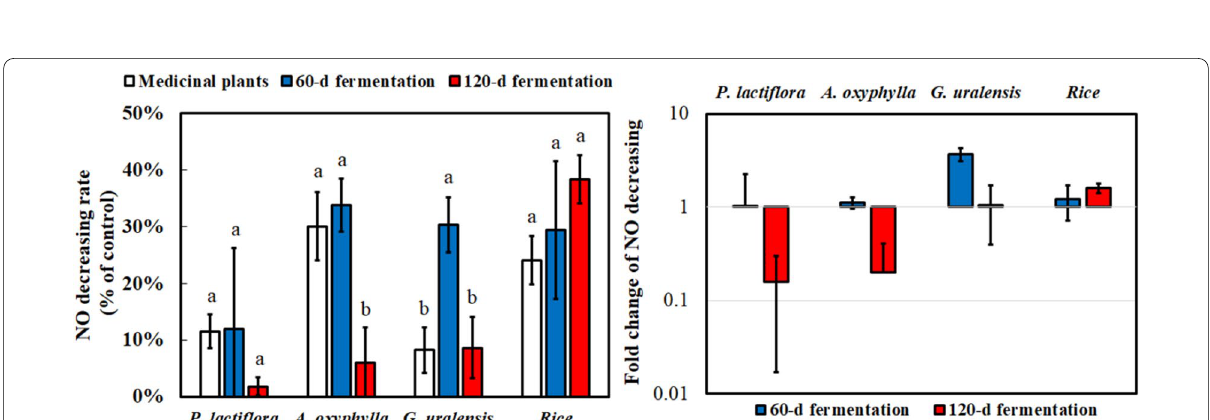
Fig. 4 Anti‑inflammatory capacity using LPS‑stimulated Raw264.7 cell with or without fermentation of medicinal plants at 0.5 mg/mL by M. ruber BCRC 31535. The ratio of 60 and 120 days of fermentation to medical plants was depicted on the right side of the figure. Results are mean (n =